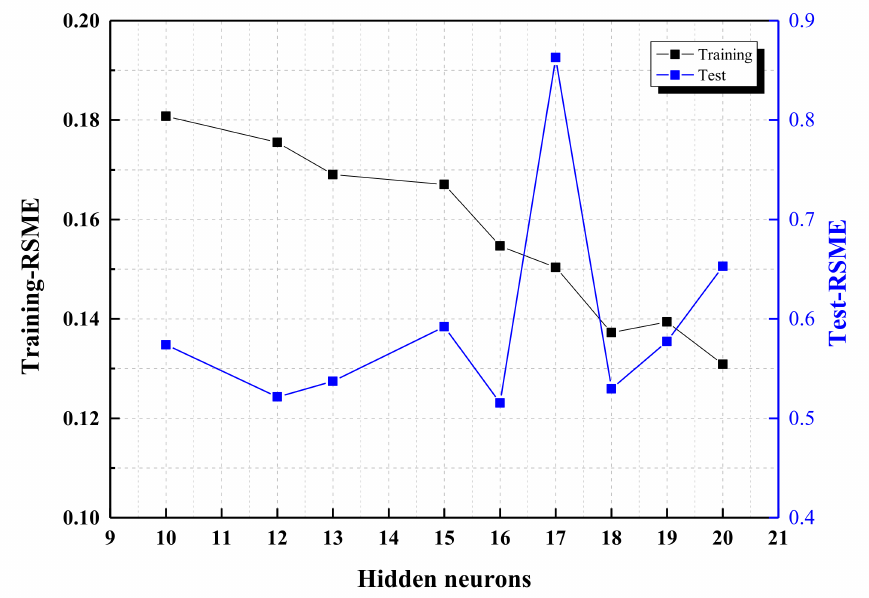
Figure 10. Comparison results of GWO-ELM models with different numbers of hidden layer